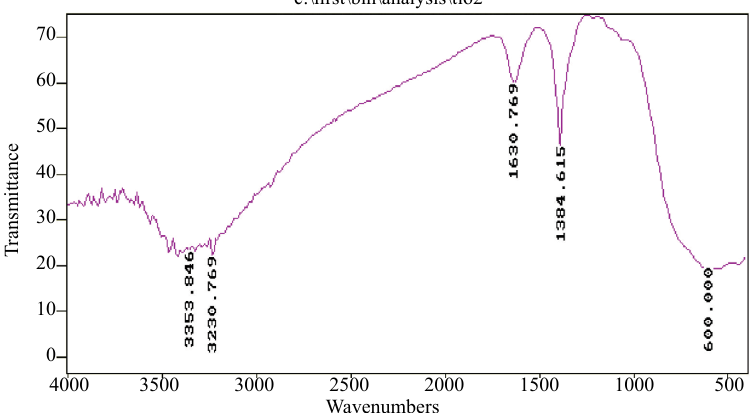
Fig. 4: FTIR spectrum of TiO